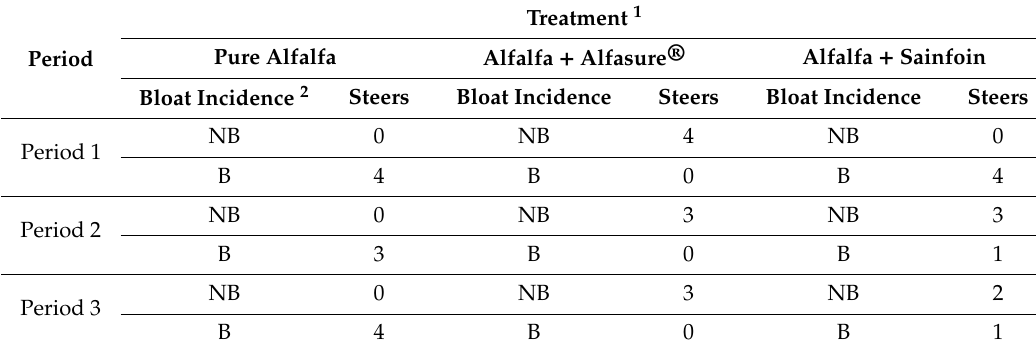
Table 1. Summary of study design and incidences of bloat in grazing